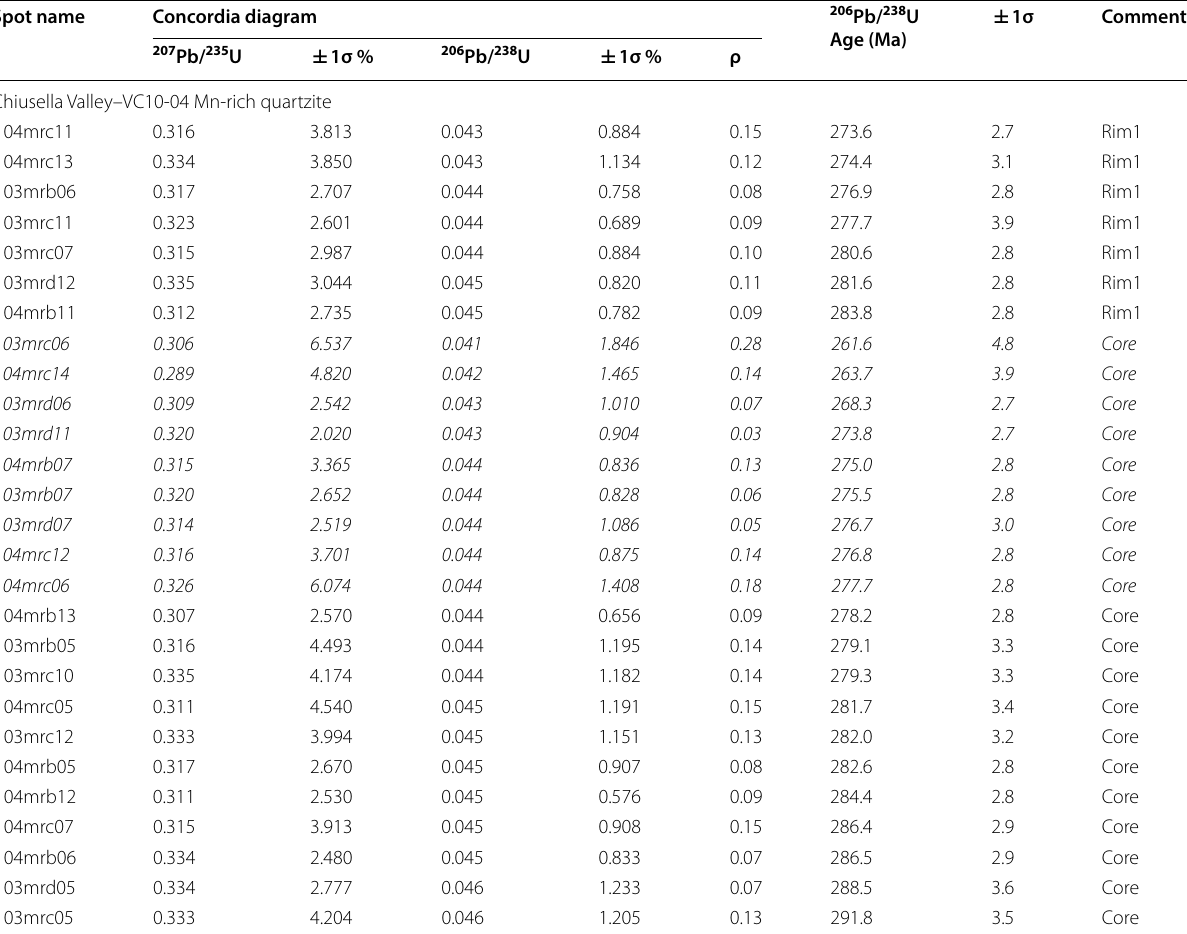
Table 6 U and Pb LA-ICP-MS zircon data of the Mn-rich quartzite VC10-04 from Chiusella Valley